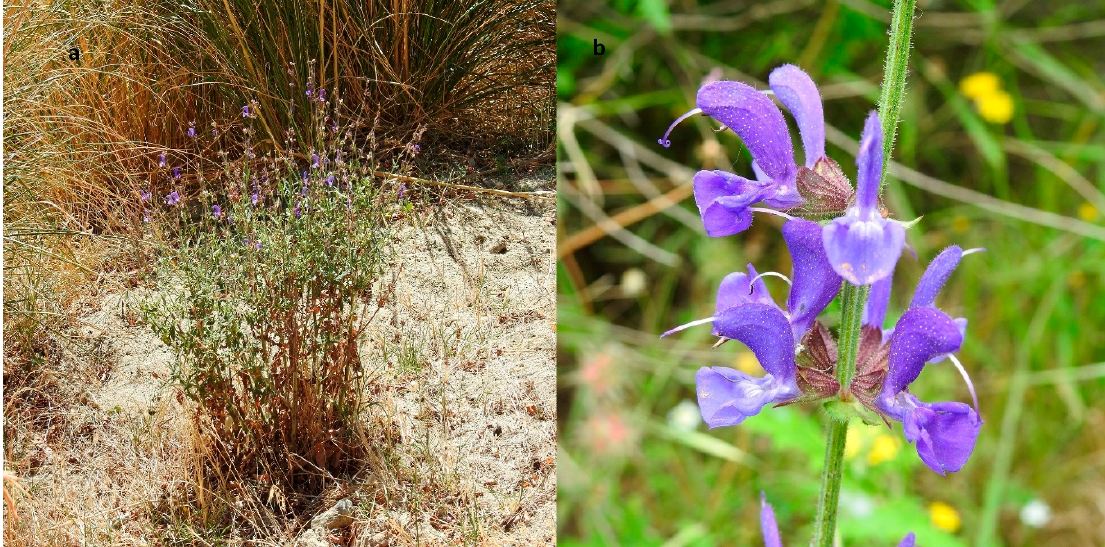
Figure 1. Salvia ceratophylloides Ard: ( a ) Plant habitat; ( b ) inflorescence in detail, with the bud and open flowers displayed in verticillasters.